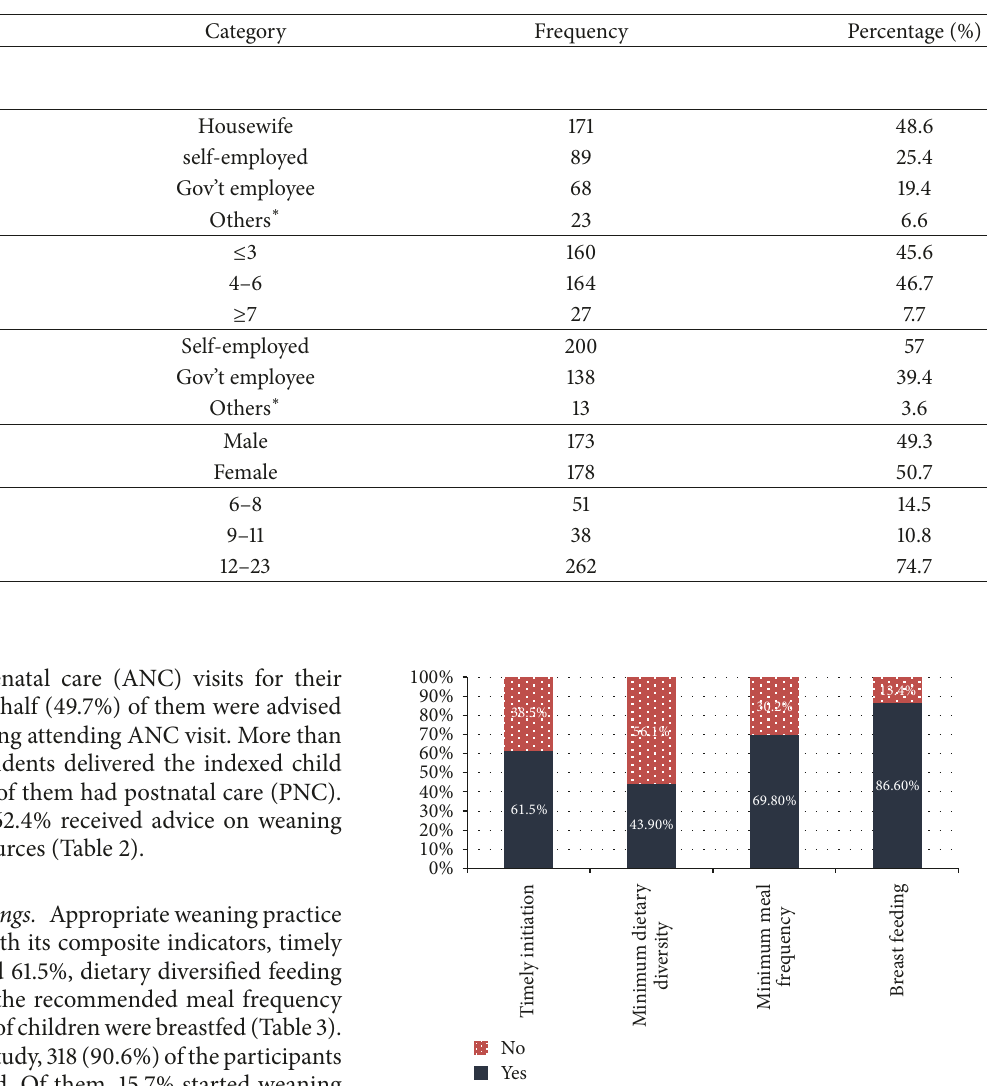
Table 1: Sociodemographic characteristics of participants in Feres Bet, Amhara, Ethiopia, 2016.